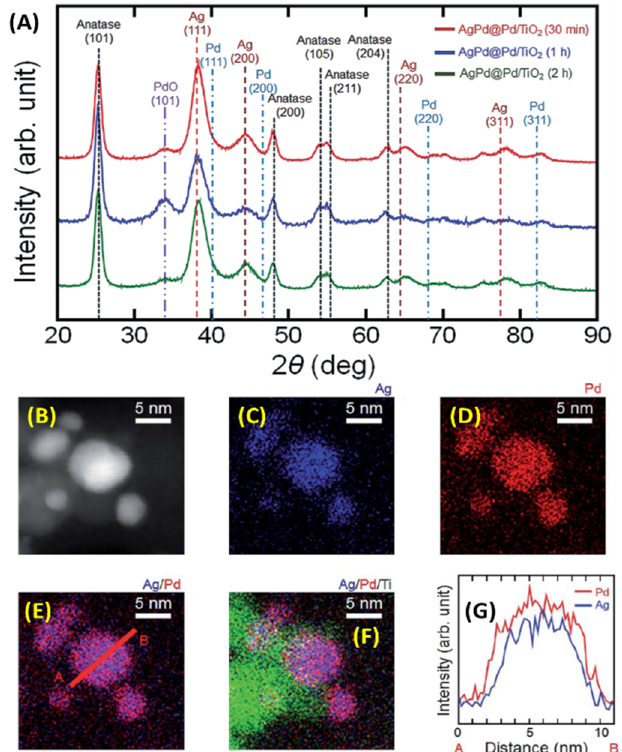
Figure 16. ( A ) PXRD data for all PdAg-Pd core-shell on TiO 2 (0.5 h) nanocatalysts; ( B ) STEM image, the corresponding 2D-mapping data ( C – F ), and the line-scan analysis ( G ) for PdAg-Pd core-shell on TiO 2 (0.5 h) sample. Adapted with permission from the American Chemical Society. Copyright 2015 American Chemical Society.